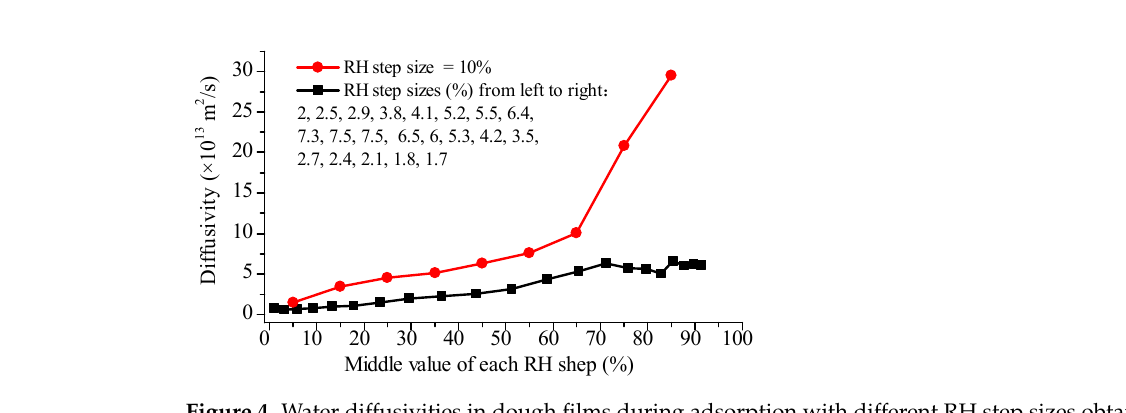
Figure 4. Water diffusivities in dough films during adsorption with different RH step sizes obtained Figure 4. Water di ff usivities in dough fi lms during adsorption with di ff erent RH step sizes obtained according to Fick’s second law. according to Fick’s second law.